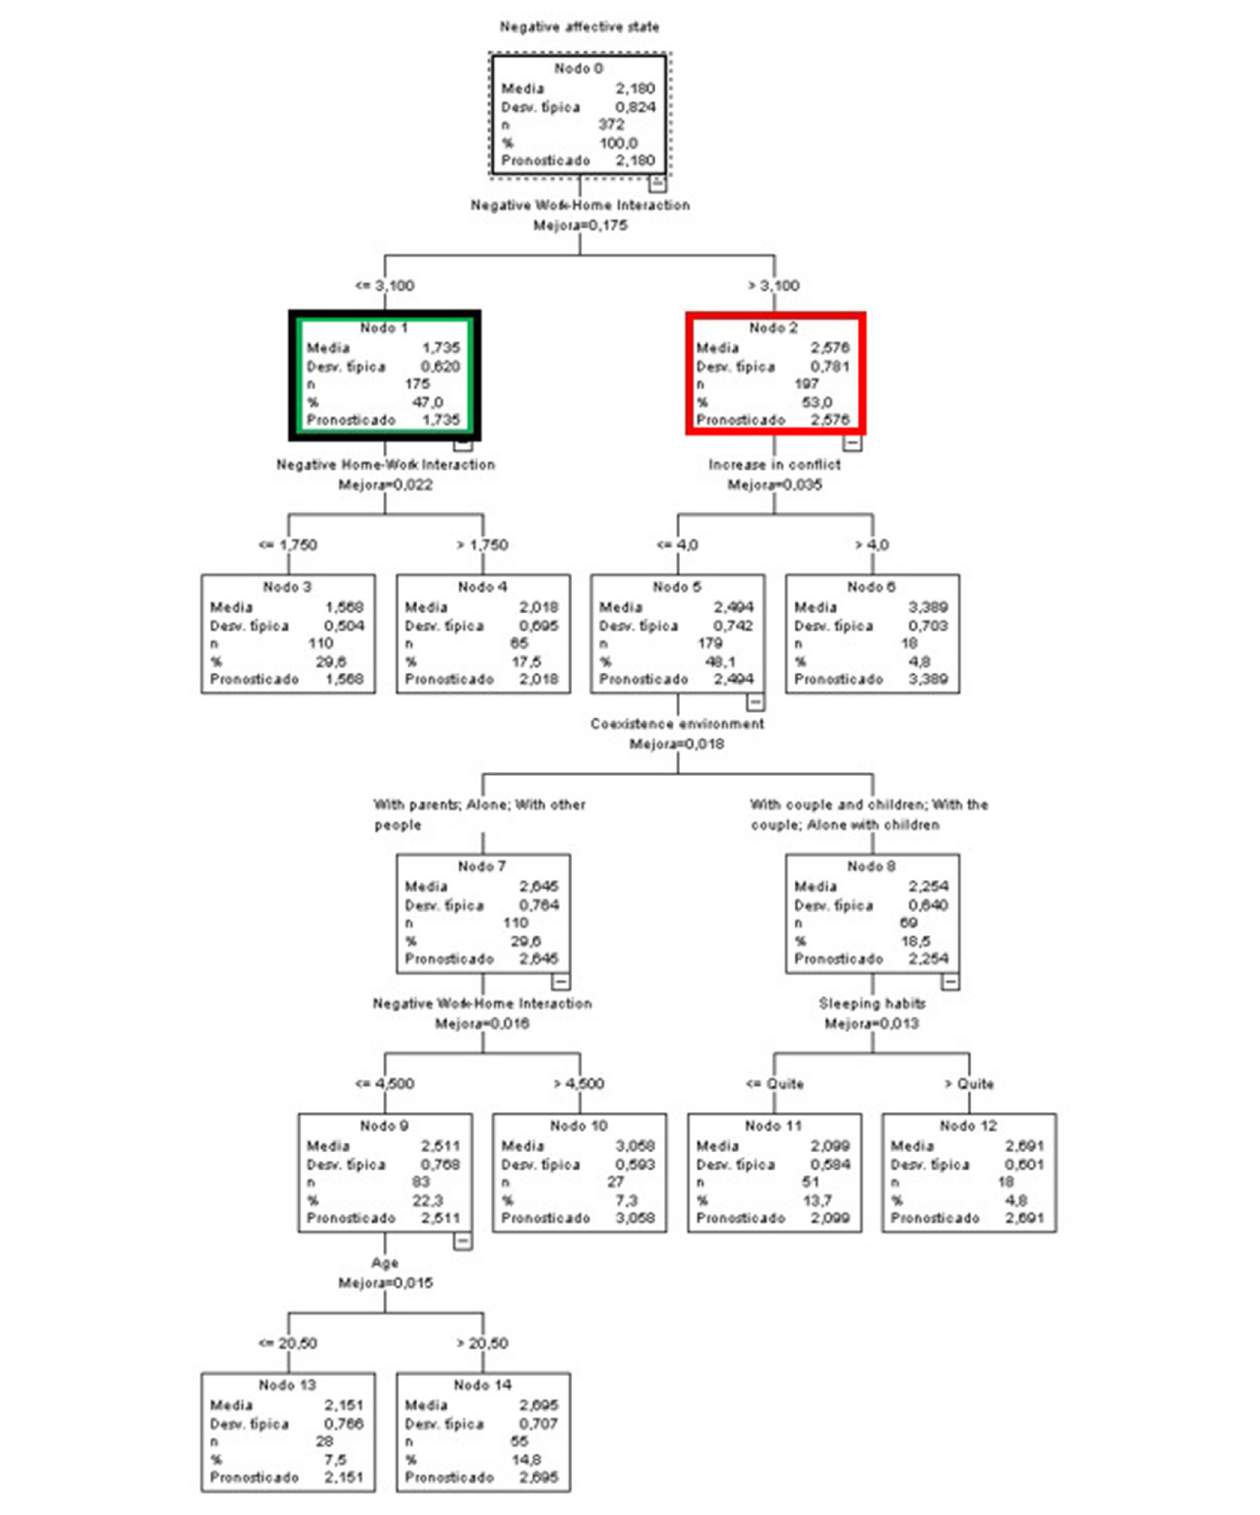
FIGURE 2 | Classificatory tree of negative affective states